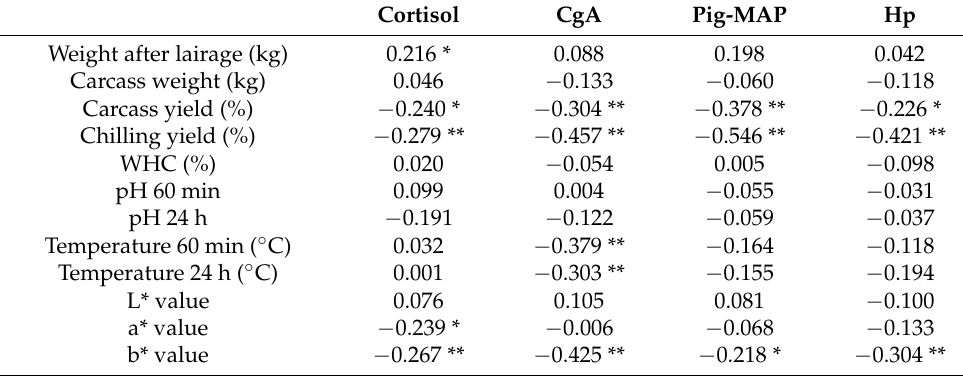
Table 6. Partial Pearson correlation between plasma levels of stress hormones and APP (log 10 values) at the bleeding point and pigs’ carcass/meat quality traits.